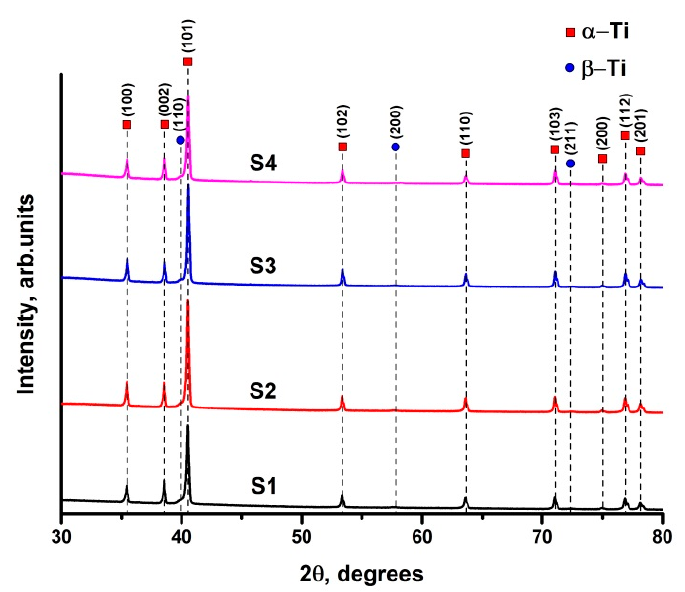
Figure 4. Diffraction patterns of Ti-6Al-4V samples produced by electron beam melting at different manufacturing parameters.